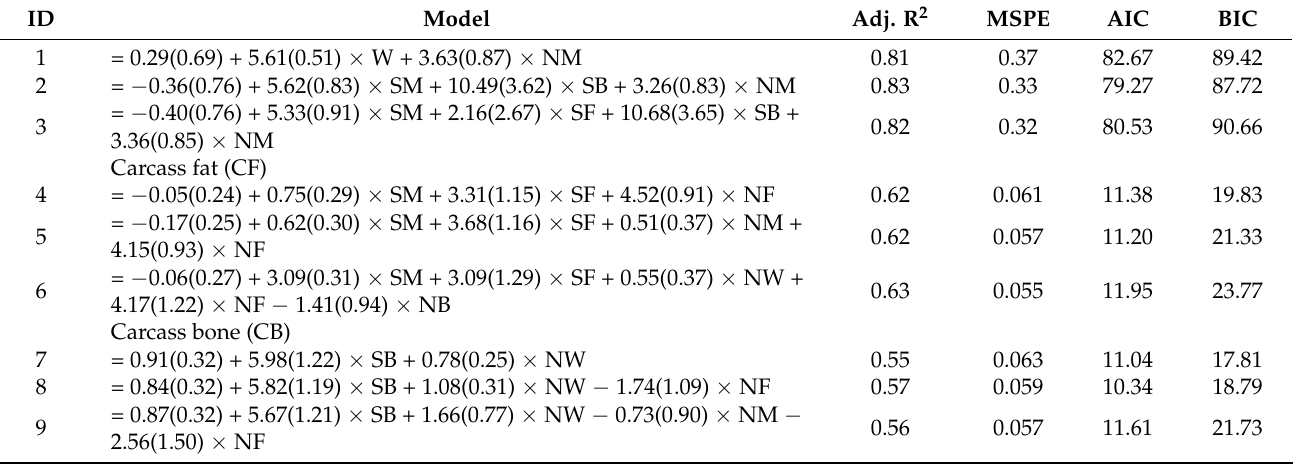
Table 2. Predictive regression equations for carcass tissue composition using the neck and shoulder tissue traits as predictors in Blackbelly male lambs ( n = 40).